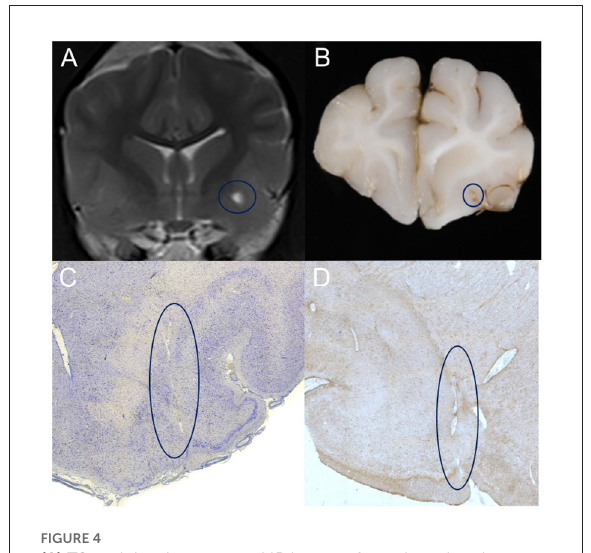
FIGURE4 (A) T2-weighted transverse MR image of a patient showing left-sided, unilateral dilated VRS on 3 Tesla MRI. Note the highlighted region (blue circle) within the grey matter of the ventral forebrain, the territory of the lenticulostriate arterioles. Corresponding macroscopic (B) and microscopic (C, D) appearance of the same area of interest in Iba.1 (C) GFAP (D) stain; note the regular round border of the dilated perivascular spaces enclosing the perforating artery in the centre and the surrounding gliotic nervous